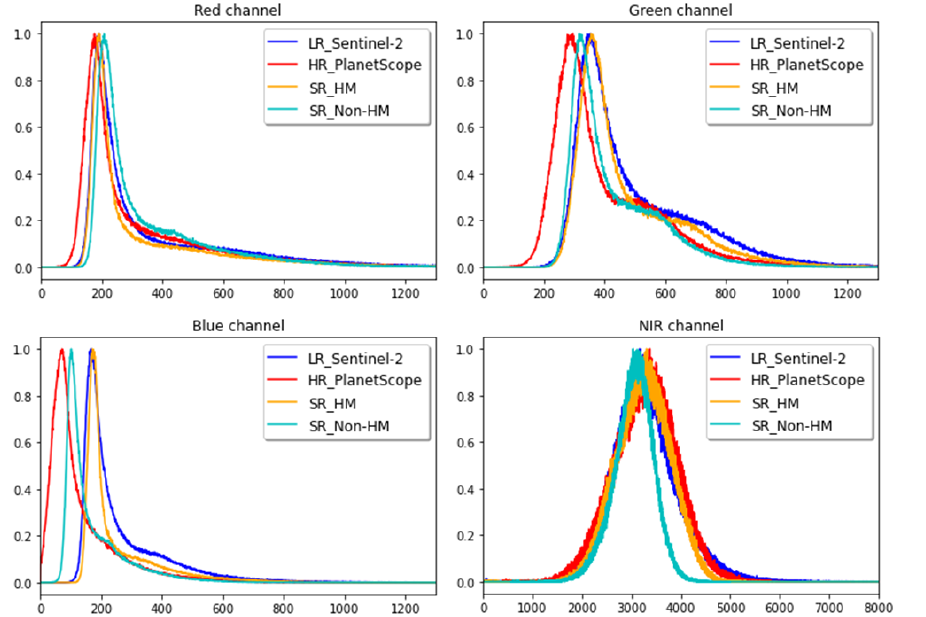
Figure 10. Normalized histograms of the LR, HR, super-resolution applying histogram matching in the pre-processing (SR_HM) and without applying Histogram Matching (SR_Non-HM) for the four bands of an image from the north west of